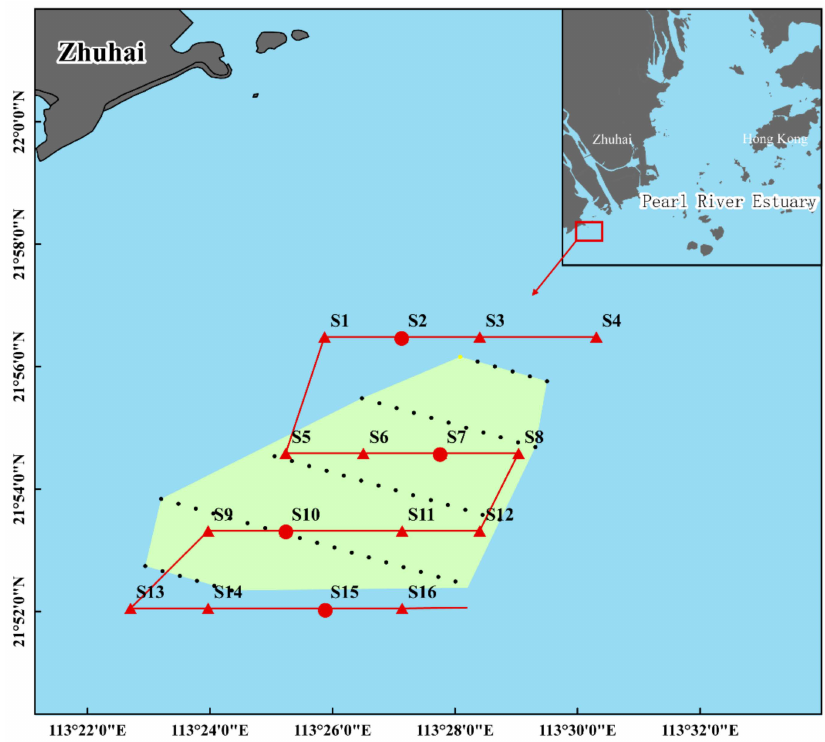
Figure 1. Map of the survey area. S1–S16 represents the number of environmental stations. (cid:78) envi- ronmental stations, (cid:108) trawl stations, • turbines constructed after the survey, • turbines constructed before the survey, OWF area, ___